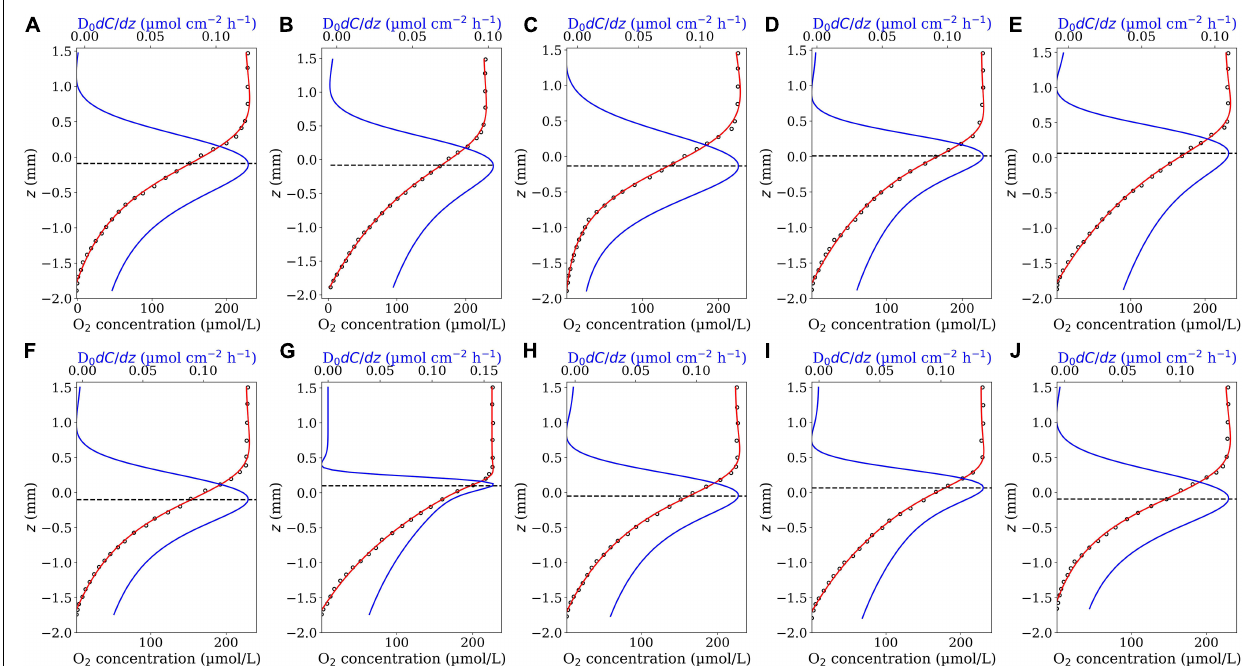
FIGURE 5 | Ten O2 concentrations profiles (A–J) measured in the sediment as a function of the z position (close circles). The data were digitalized from Figure 2 in Jørgensen and Revsbech (1985). The red curves are the best fit of Eq. 7 on the profiles. The blue curves represent the corresponding diffusive flux functions (Eq. 8 multiplied by the diffusion coefficient). The horizontal dashed lines indicate the position of the sediment-water interface (corresponding to the maximum diffusive fluxes).